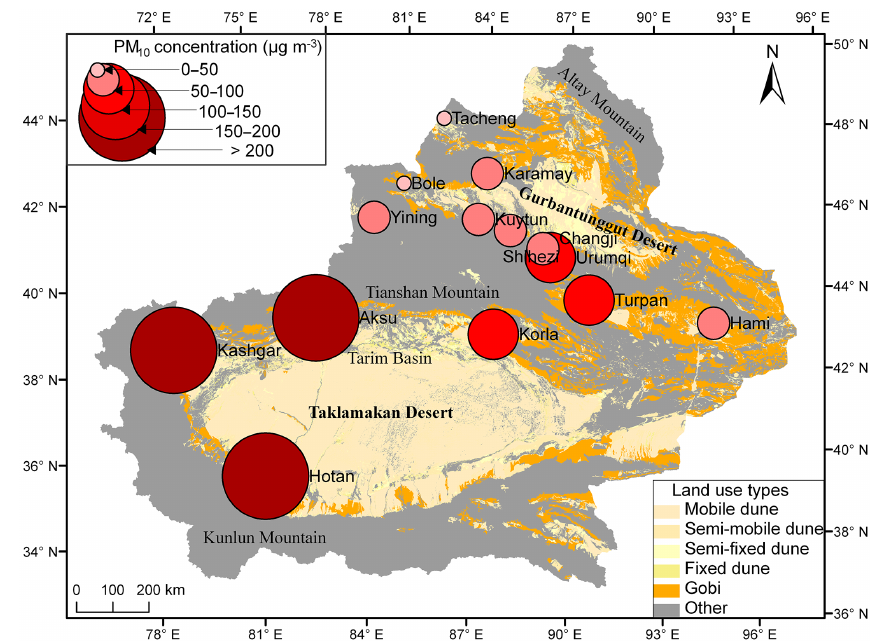
Figure 5. Annual average PM 10 concentration reported for 14 stations in Xinjiang Province from 2000 to 2013. Land use types are identified across the province according to Wang et al.